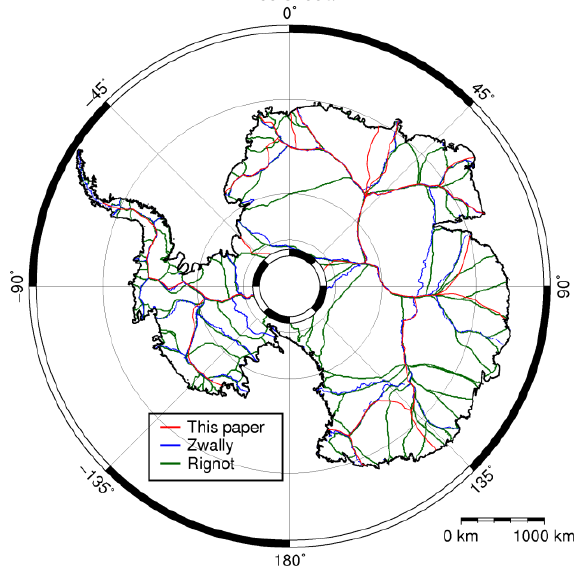
Figure 7. Comparison of the ice divides of this paper (red borders) and Zwally et al., 2012 (blue borders) and Rignot et al., (2008) (dark green